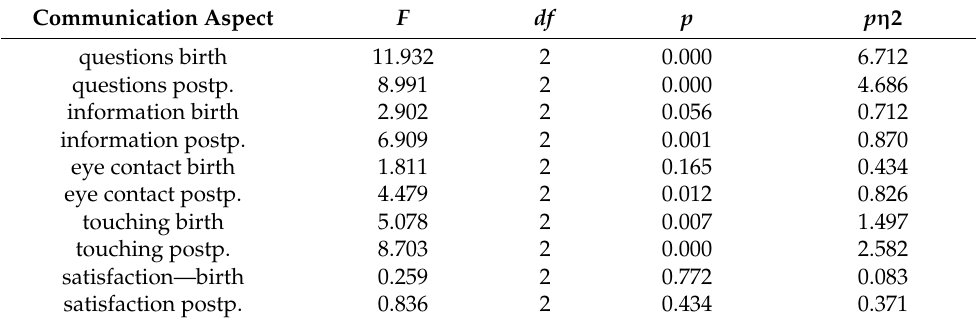
Table 3. Results of the one-way ANOVA analysis with the perception of childbirth risk as the differentiating variable and each of the communication aspects as dependent